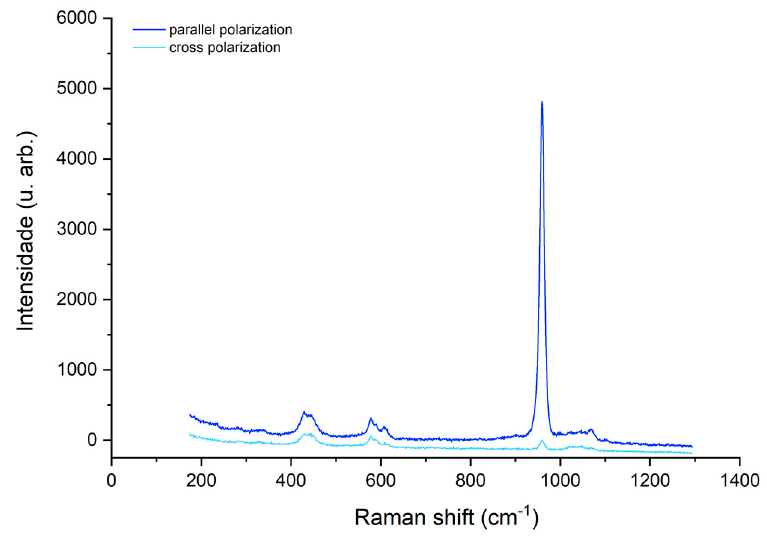
Figure 3. Spectra of a hypomineralized white opacity before treatment with GC Tooth Mousse.